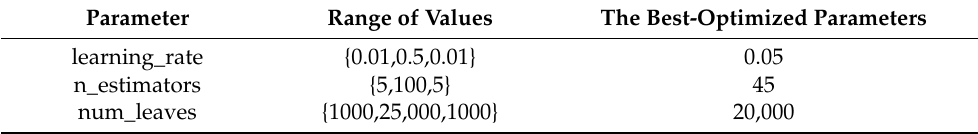
Table 4. Parameter settings for the light gradient boosting machine (LightGBM) algorithm.